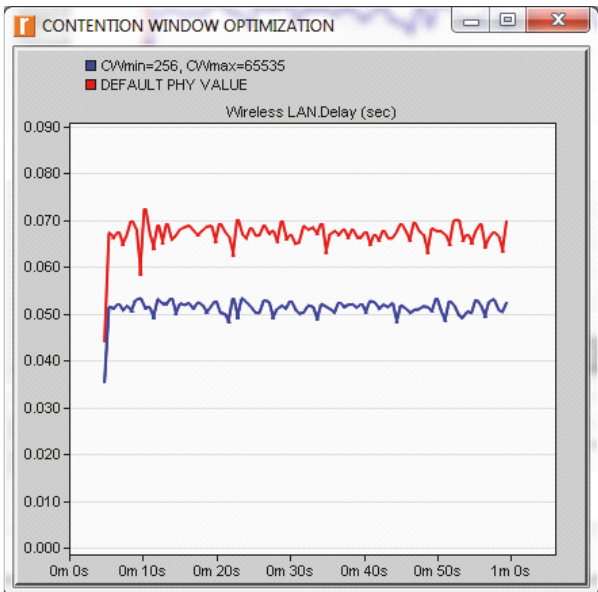
Figure 34: WLAN delay with and without Contention Window optimization.